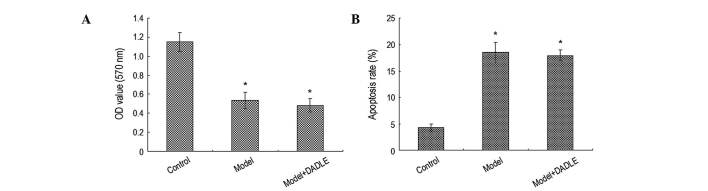
MKK7 knockdown reverses the protective effect of DADLE on intestinal epithelial cells following ischemia/reperfusion. (A) Analysis of cell viability using an MTT assay. (B) Analysis of apoptosis using flow cytometry. Each independent experiment was repeated in triplicate. Data are presented as the mean ± standard deviation. *P<0.05, compared with the control group. DADLE, (D-Ala2, D-Leu5)-enkephalin; Model, ischemia/reperfusion; MKK, mitogen-activated protein kinase kinase; OD. optical density.